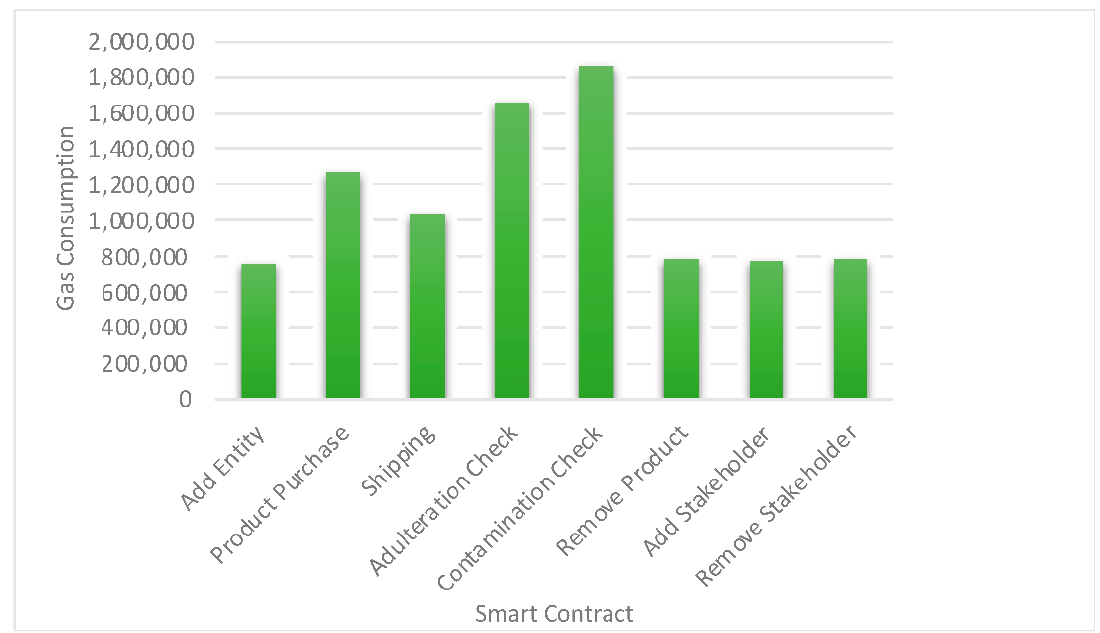
Figure 7. Gas Consumptions specific to smart contract execution.